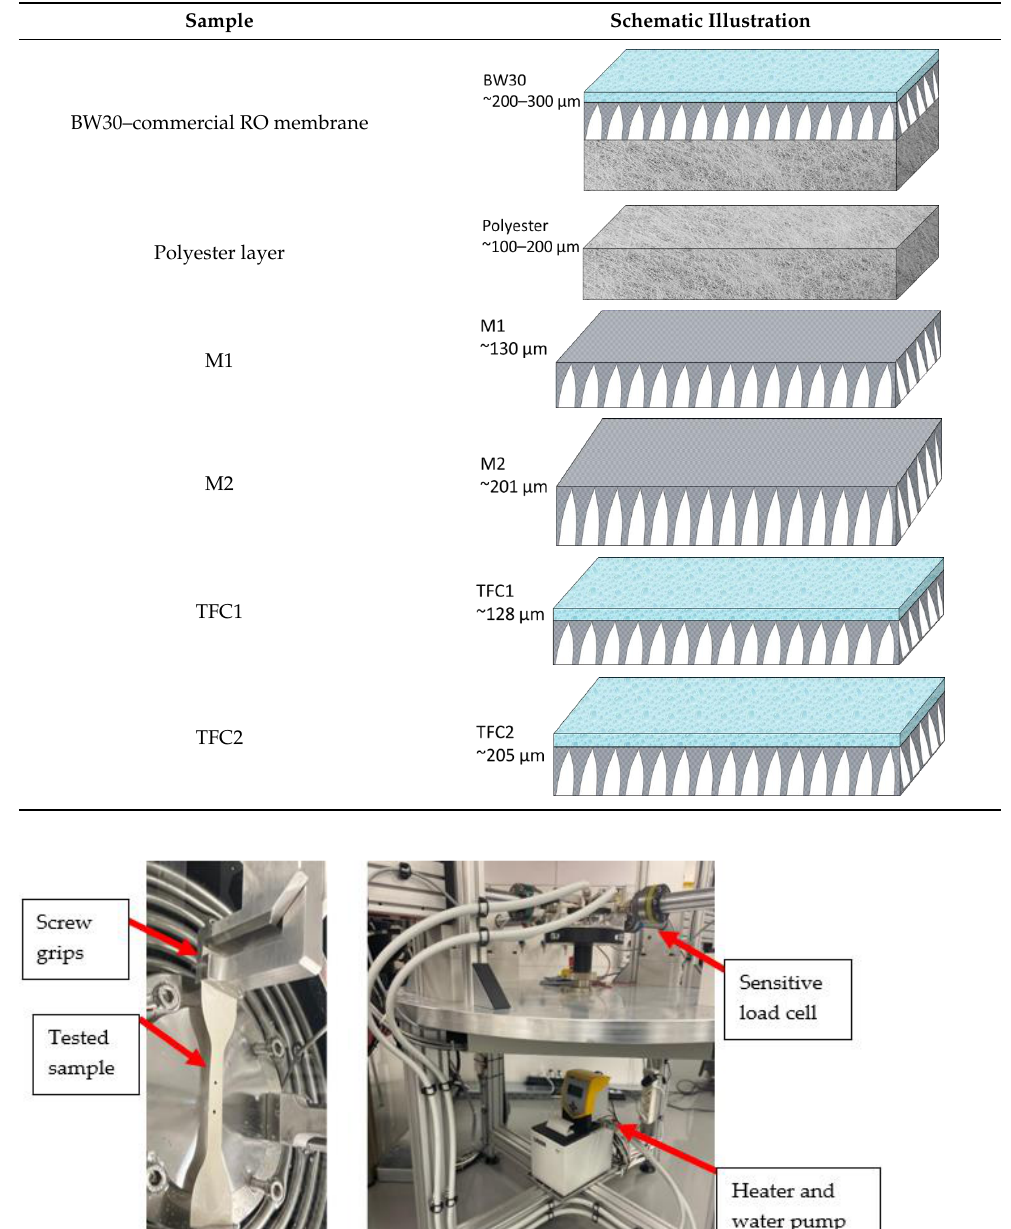
Table 2. Schematic illustration of the types of the tested membranes.